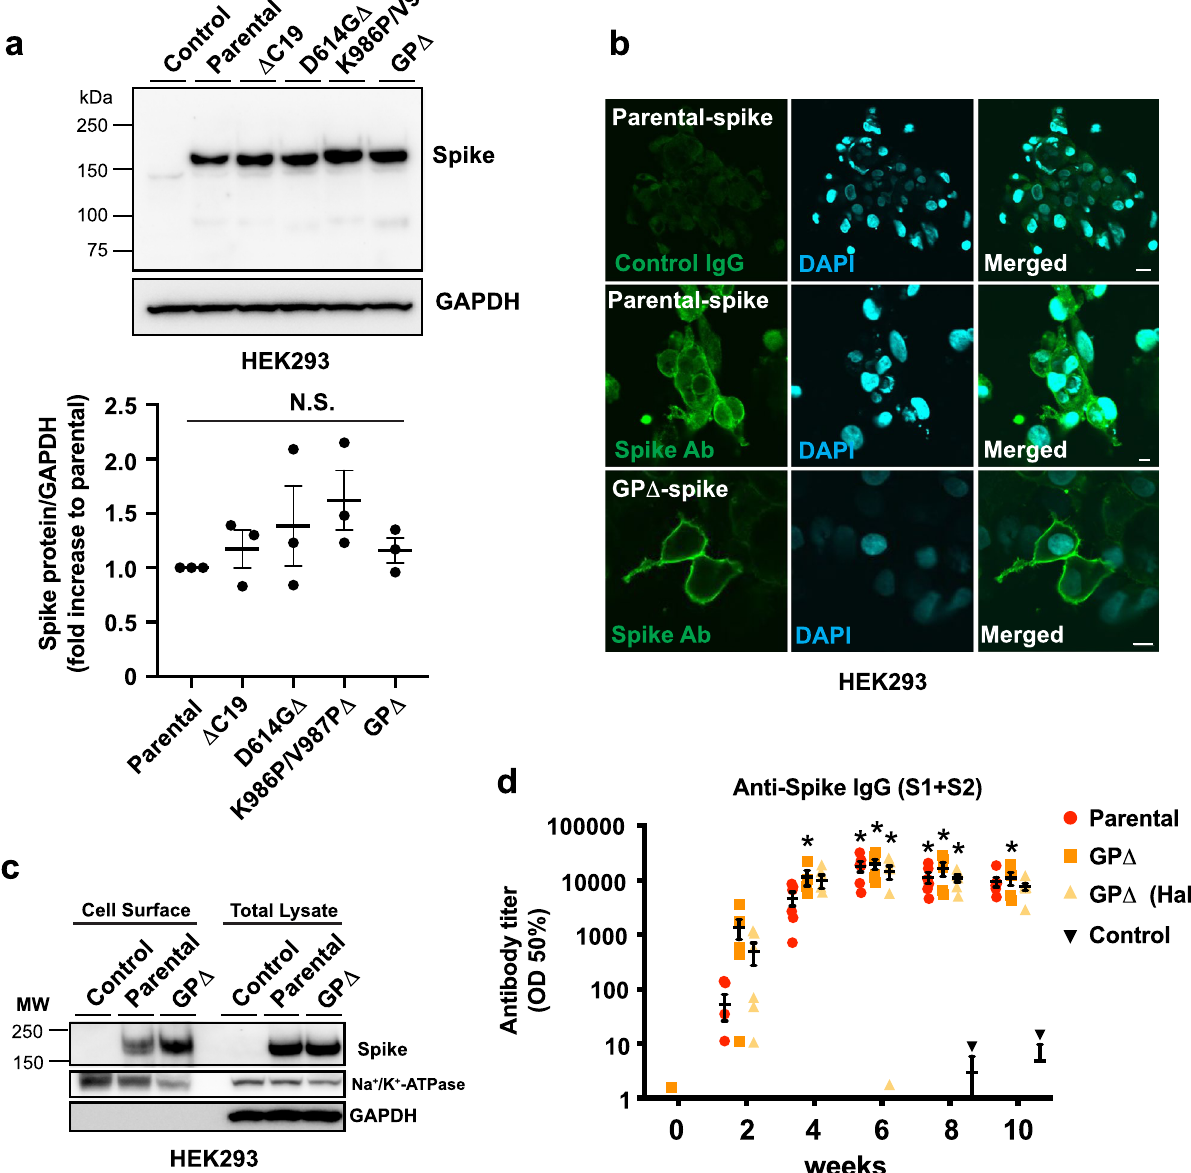
Figure 1. Development of modified DNA vaccine construct. ( a ) Expression of each or all mutated spike glycoprotein in HEK293 cells evaluated through western blotting. Spike was detected using polyclonal SARS- CoV-2 spike antibody (GTX135356, GeneTex). GAPDH was used as a loading control. Lower graph shows the ratio between spike protein and GAPDH, analyzed by densitometric measurement. ( b ) Localization of the spike glycoprotein expressed by the parental DNA vaccine construct, or the GP∆-DNA vaccine construct, assessed through immunostaining in HEK293 cells. Nuclei were stained by DAPI. Scale bars: upper panel (control IgG) = 20 μm, lower 2 panels (anti-Spike Ab) = 10 μm. ( c ) Spike expression on the cell membrane, assessed using cell surface protein isolation. Spike was detected using monoclonal SARS-CoV-2 spike antibody (#42172, Cell Signaling Technology). α1-Na + /K + -ATPase expression was used as a loading control for isolated surface proteins. ( d ) GP∆-DNA vaccine-induced antibody titer determined using ELISA. Parental DNA vaccine (666.6 μg); Parental, GP∆-DNA vaccine (666.6 μg); GP∆, or half amount of GP∆-DNA vaccine (333.3 μg); GP∆ (Half), with alum adjuvant was intramuscularly injected into male SD rats three times at 2-week intervals. Control rats were not treated. The antibody titer was evaluated for 10 weeks after the first vaccination using ELISA. *p < 0.05 vs. control group (Two-way ANOVA with Tukey’s multiple comparison test). Data are shown as mean ± SEM. See also Supplementary Figs.